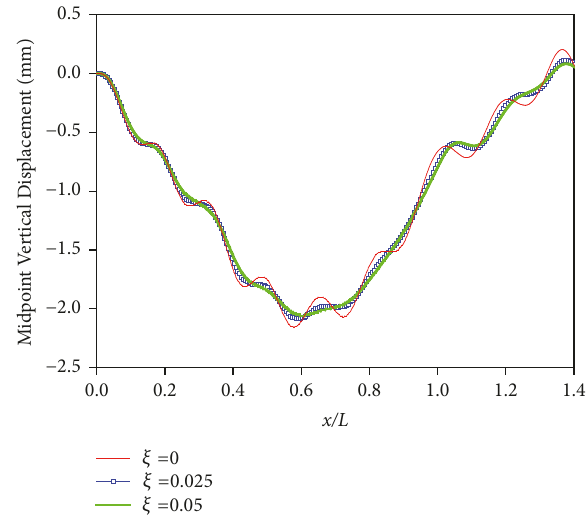
Figure 17: Vertical displacement of midpoint of simply supported beam with different